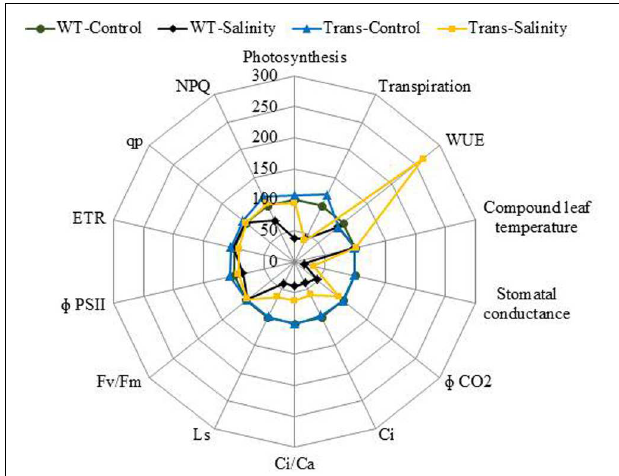
FIGURE 11 | The radar diagram built by comparing all the photosynthesis related parameters between WT and transgenic plants (average of three transgenic lines) under control and 300 mM NaCl